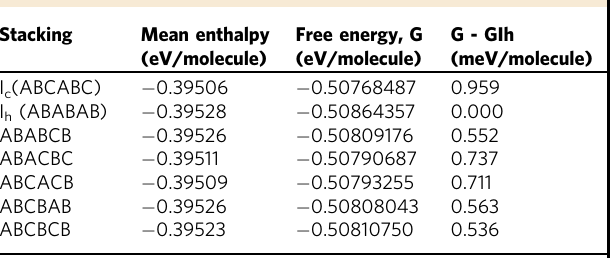
Table 6 Mean enthalpy and free-energy of various ice polytypes predicted by ML-BOP